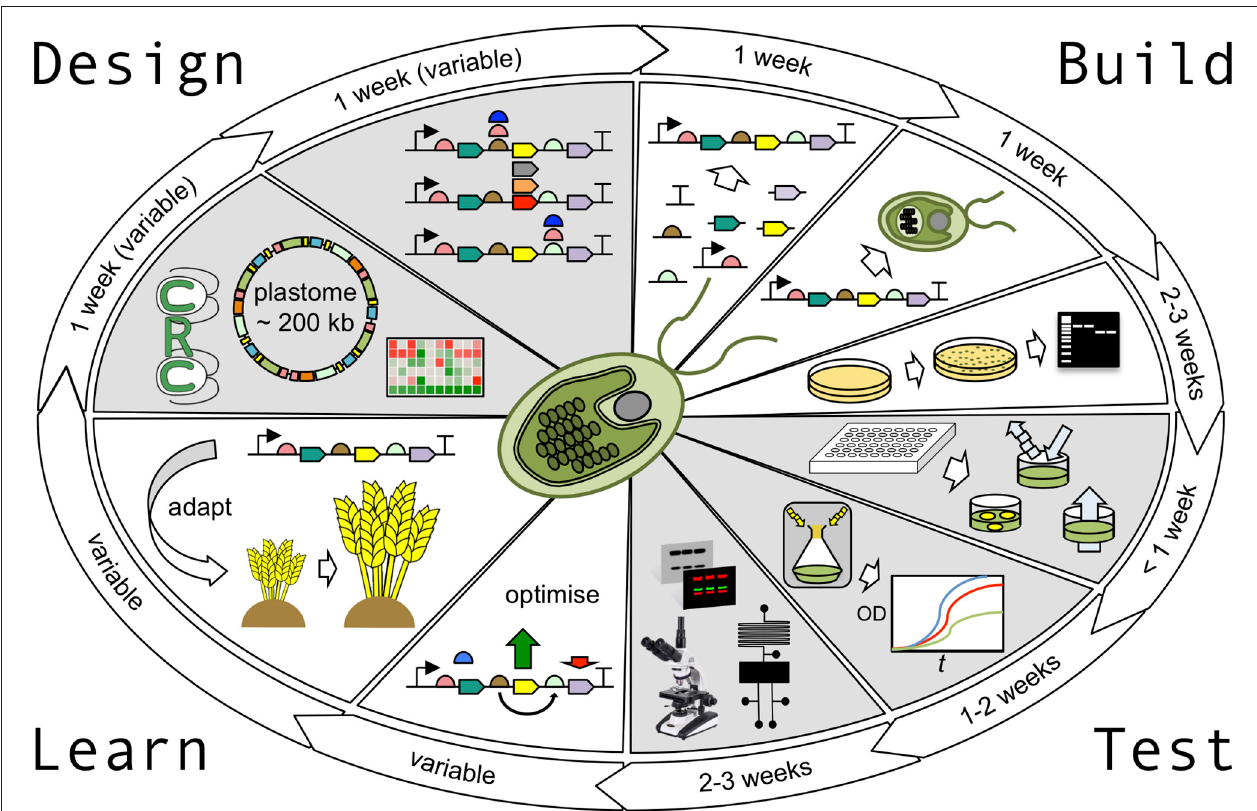
FIGURE 1 | The Chlamydomonas plastid testbed. The design stage of the Design-Build-Test-Learn (DBTL) cycle is supported by the availability of accurately detailed genomic and transcriptomic information and a vast library of parental mutant strains, readily available from the Chlamydomonas Resource Center. Golden Gate cloning strategies can be used to design parallel builds of multiple construct variants with ease. In the build phase, these constructs can then be assembled in one-pot cloning reactions to generate validated plasmids in less than a week. The chloroplast transformation procedure takes ∼ 1 week, including culturing time, with colonies taking ∼ 1 week to appear and a further ∼ 3 weeks to generate homoplasmic transgenic cell lines. In the test phase, rapid absorbance, fluorescence, and luminescence assays can be carried out in < 1 week to screen cell lines before more robust growth analysis (1–2 weeks), and sophisticated physiological analysis is performed (2–3 weeks). Depending on the output of the test phase, designs can either be optimised further or adapted for use in higher plants. The entire DBTL cycle can be as short as 10–13